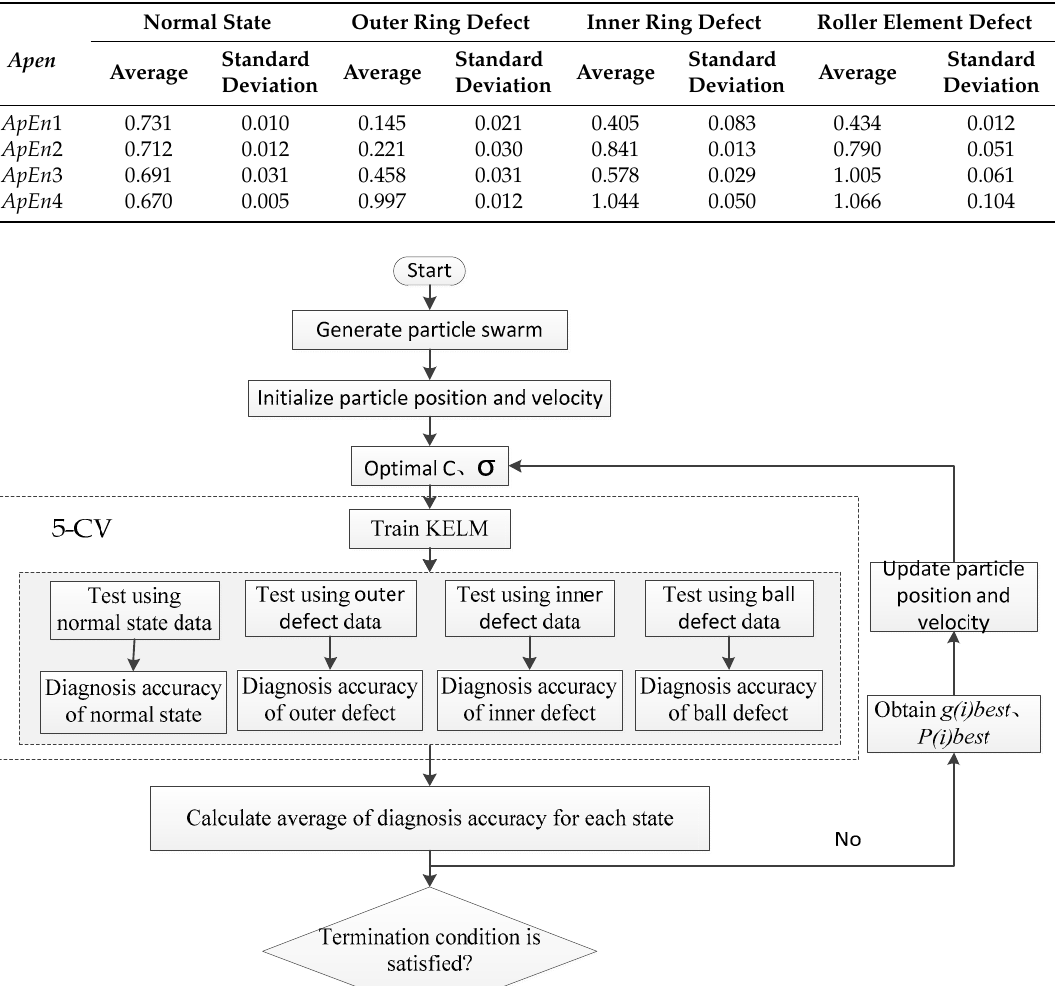
Table 3. Distribution information of the ApEn .